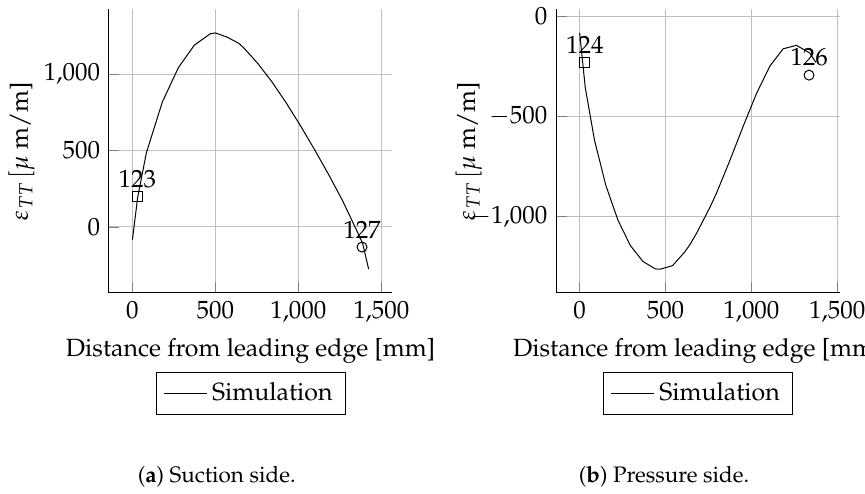
Figure A49. Strain comparison ε LL at radial position R = 13,000 mm for Mymin load case.